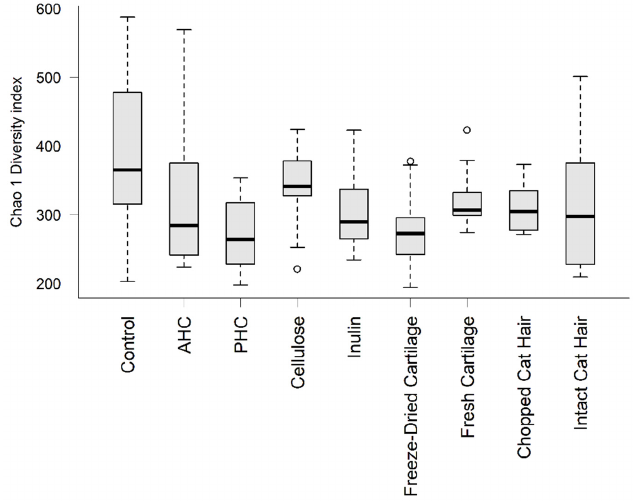
Figure A2. Assessment of alpha diversity using the Chao1 diversity index from samples following in vitro fermentation of substrates at the 24-h time point using high protein faecal inoculum (PD). Small circles denote outliers.